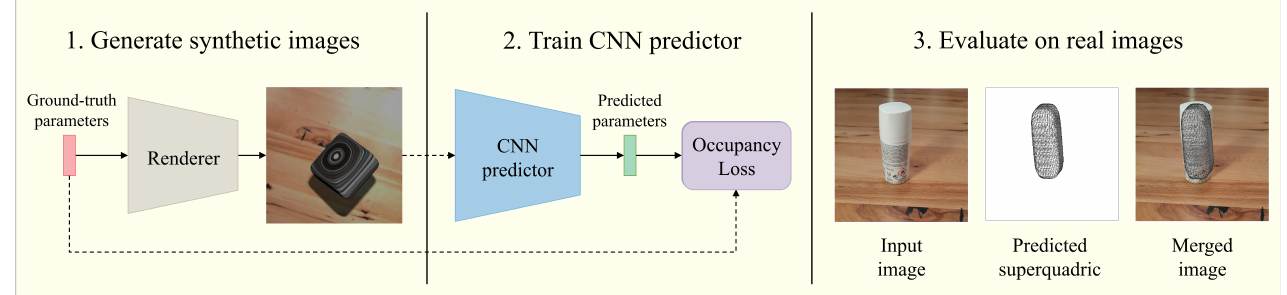
Figure 1. Visualized overview of our reconstruction method. (1) Generate a large dataset of synthetic images that mimic the real environment. Each image contains a randomly positioned superquadric of a random shape. (2) Train the CNN predictor on the synthetic dataset to predict superquadric parameters. (3) Use the final CNN predictor ( Textured on Wood (Fixed z) with Sh. & S.L. ) on real images to reconstruct simple objects as